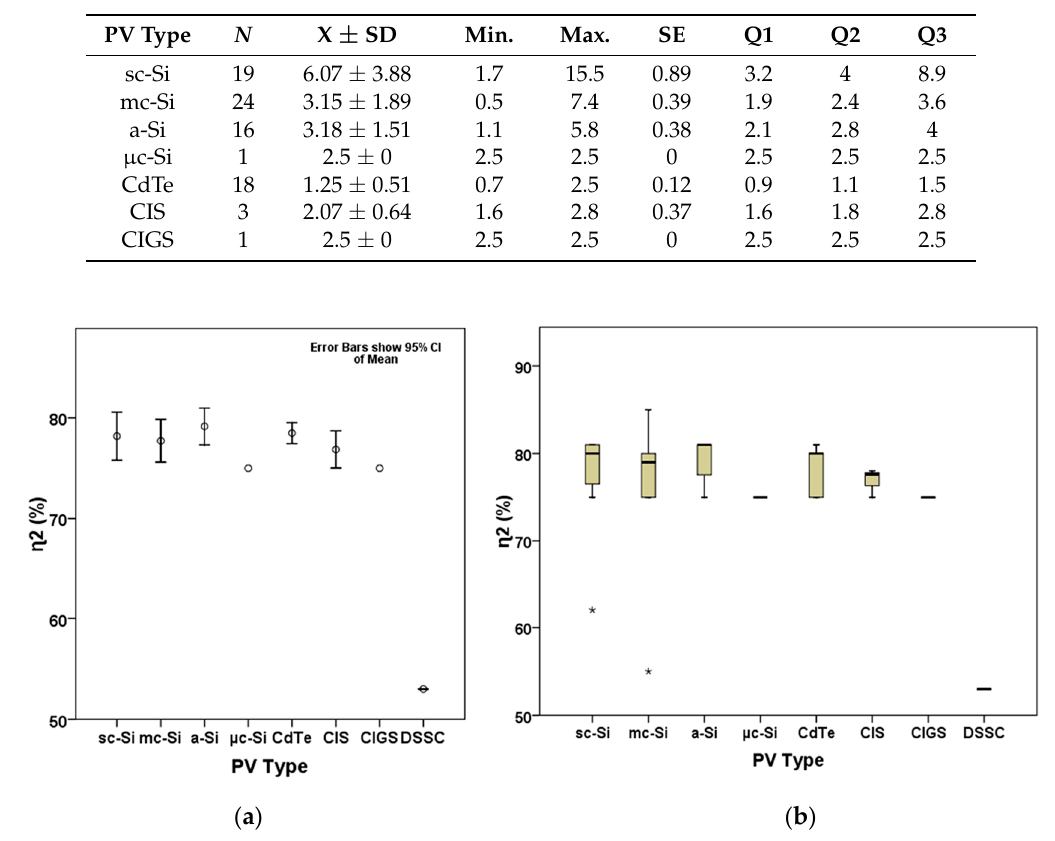
Table 4. EPBT period (years) statistics for PV electricity generation systems.